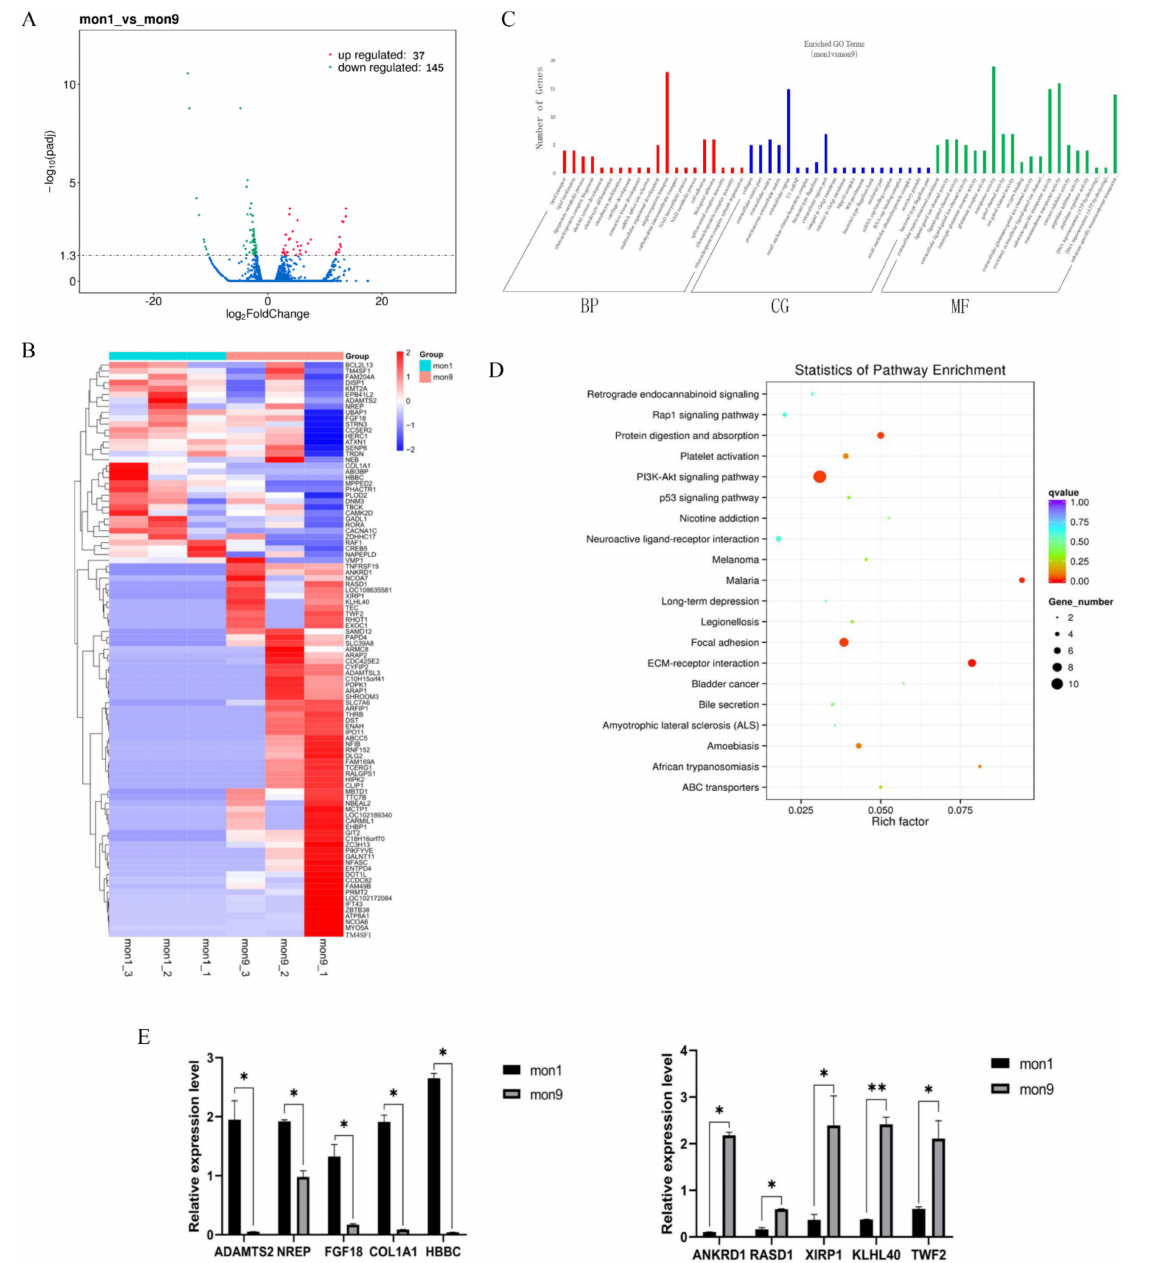
Figure 2. mRNA sequencing and analysis of differentially expressed genes (DEGs): ( A , B ) Volcano plot and heatmap of DEGs between mon1 and mon9. ( C , D ) Identified GO terms and KEGG pathways for the DEGs. ( E ) DEG verification by RT-qPCR and sequencing. * p < 0.05; ** p <